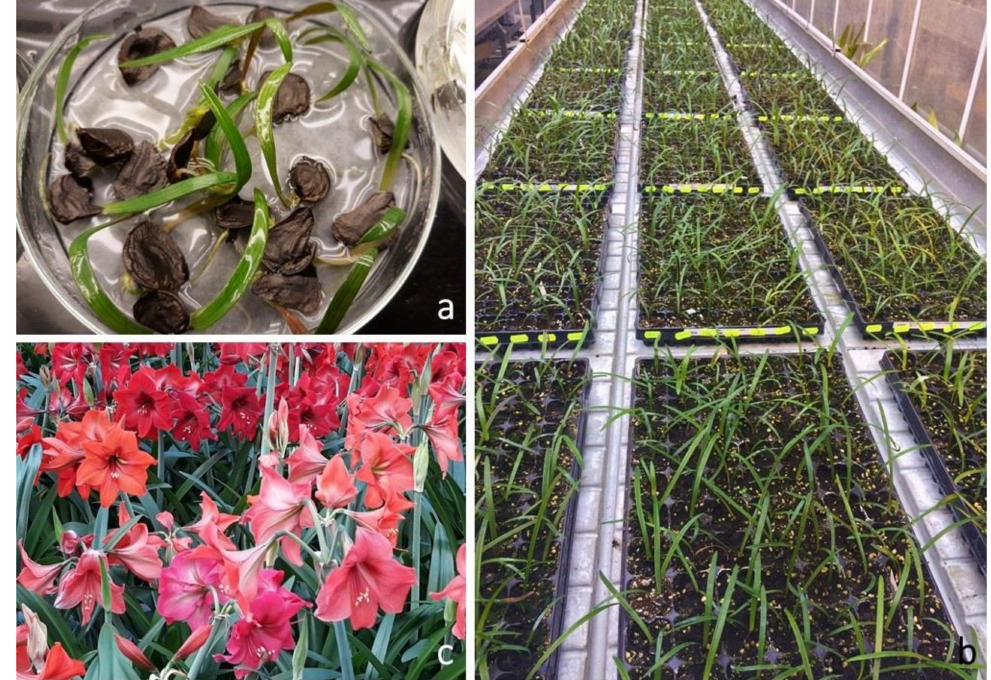
Figure 1. A breeding programme of Hippeastrum × chmielii at Warsaw University of Life Sciences, Poland. ( a ) Seed germination on petri dishes; ( b ) hybrid seedlings in their juvenile phase under green- house conditions; ( c ) flowering of the seedlings’ population en masse in the third year after